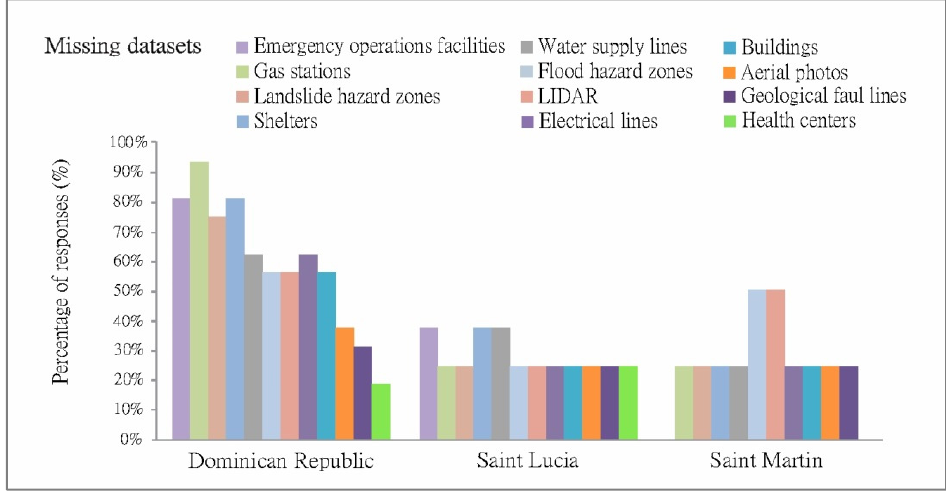
Figure 7. Missing datasets for improving the EMT operations (Q23).